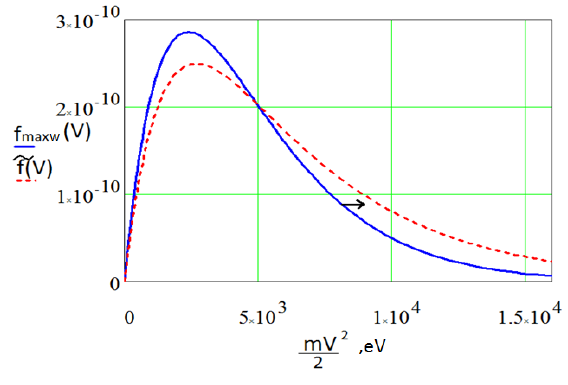
Fig. 1. Velocity distribution functions in terms of kinetic energy.